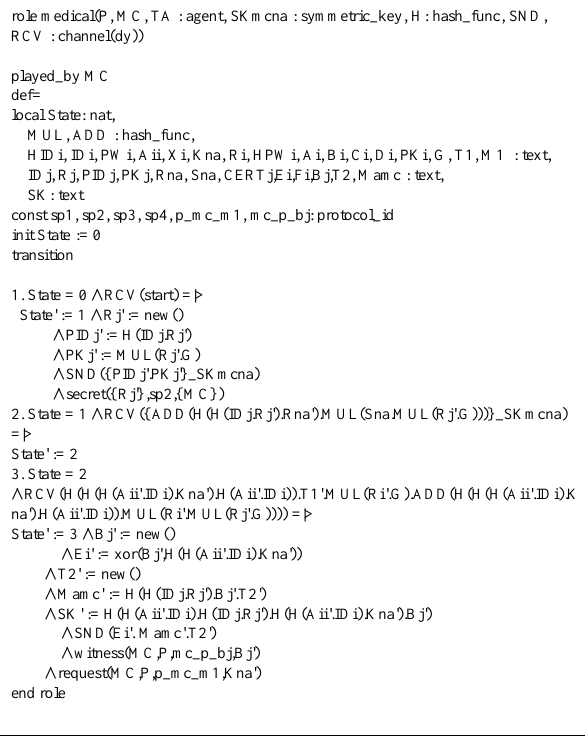
Figure 10. HLPSL syntax of medical